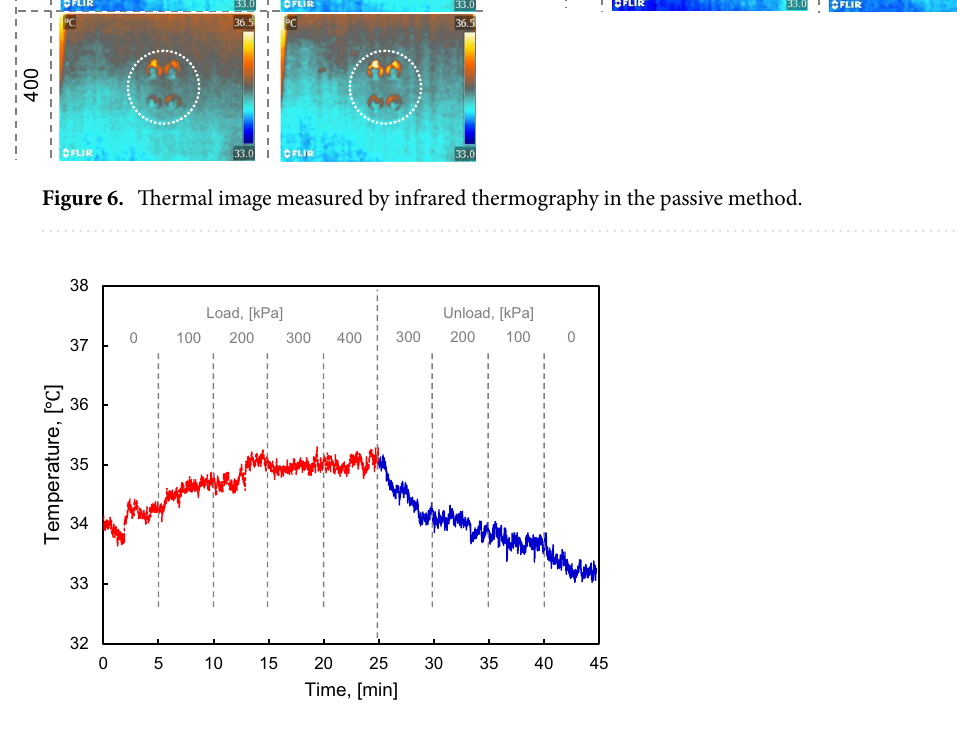
Figure 7. Average temperature change versus elapsed time at each loading step in the passive